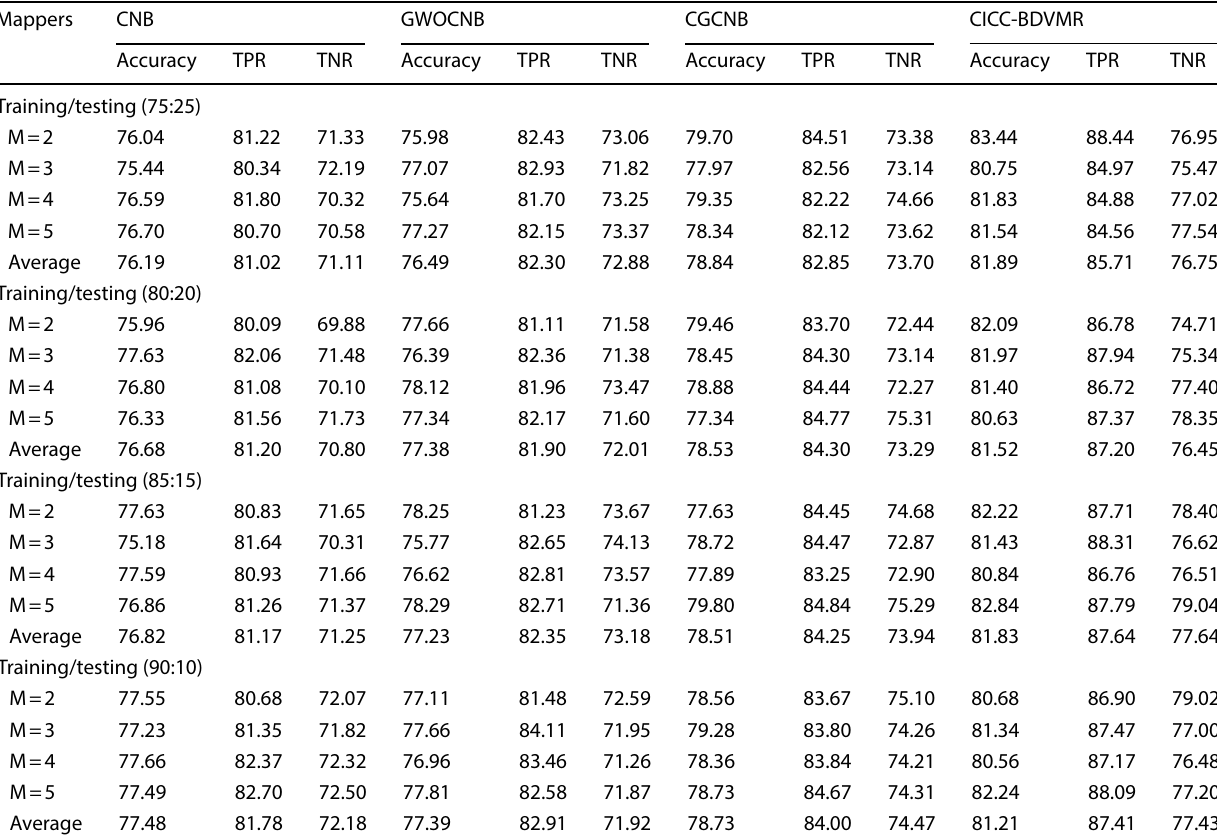
Table 3 Result analysis of CICC-BDVMR technique under different mappers in skin dataset